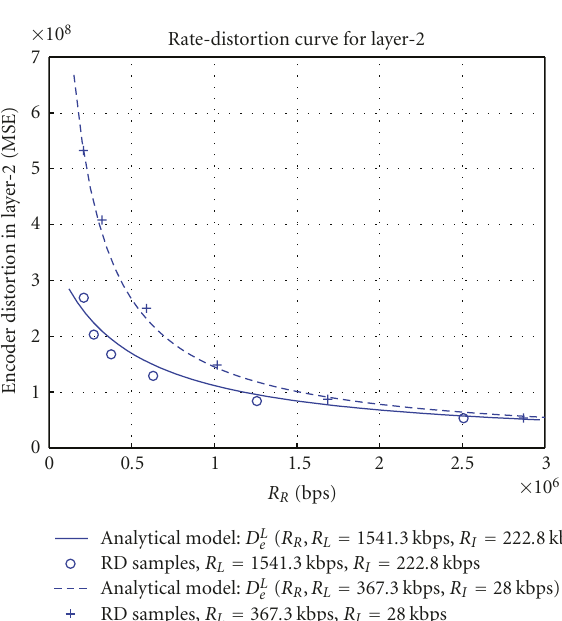
Figure 9: RD curve for layer 2 of the “Soccer” video.